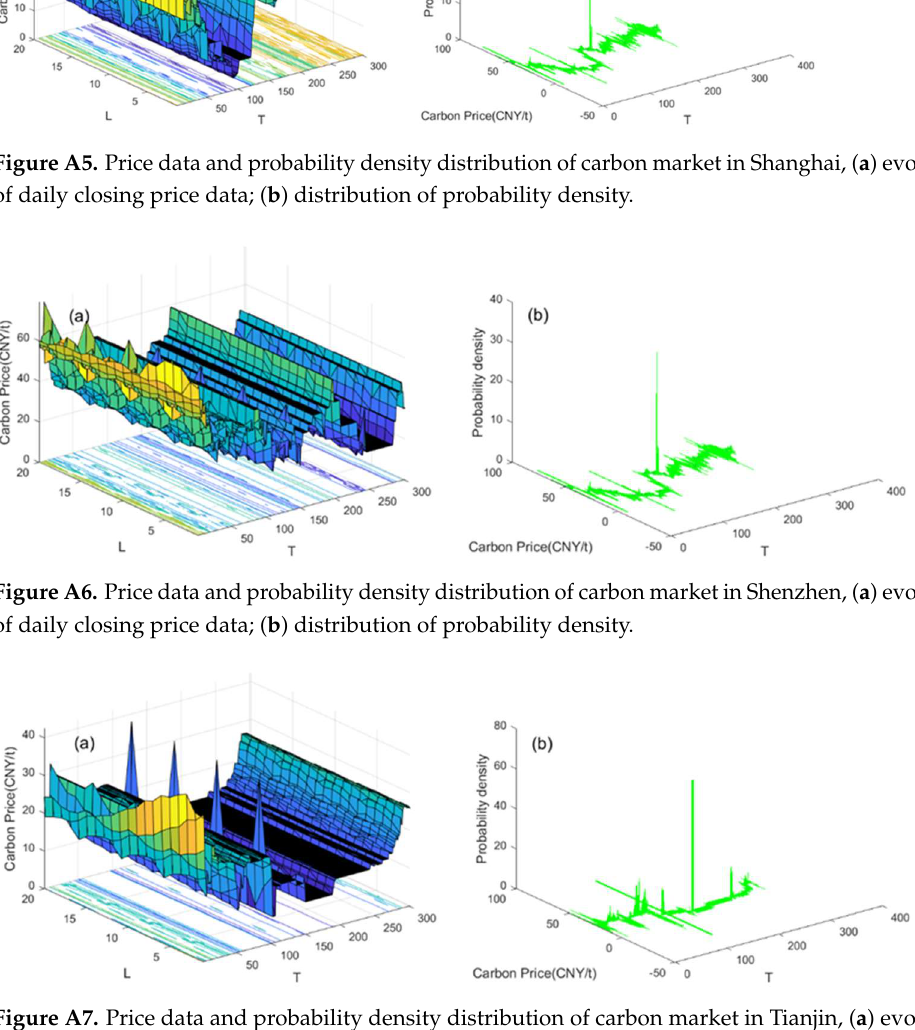
Figure A7. Price data and probability density distribution of carbon market in Tianjin, ( a ) evolution of daily closing price data; ( b ) distribution of probability density.